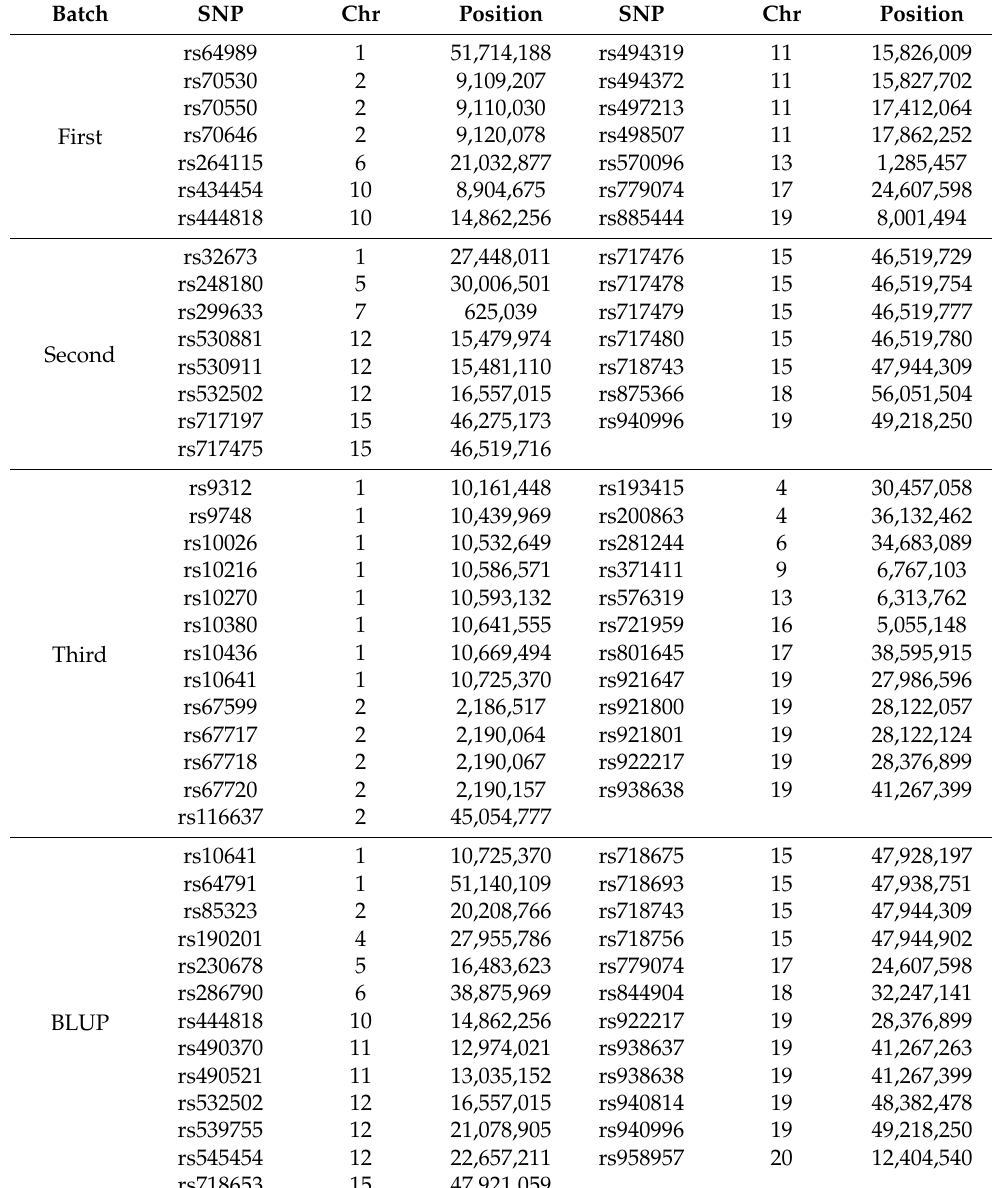
Table 4. SNPs associated with G. soja resistance to P. sojae